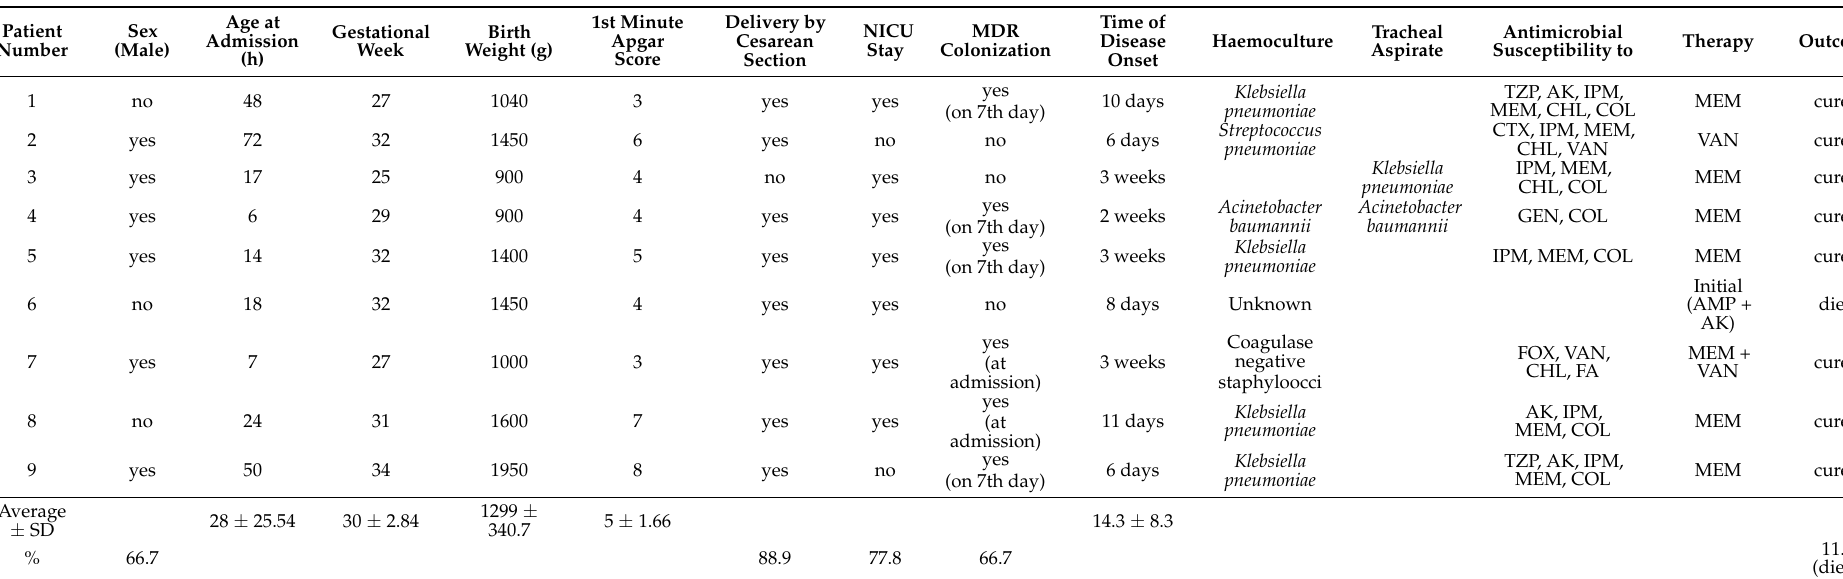
Table 2. Demographic and clinical characteristics, colonization with multidrug-resistant (MDR) bacteria, causative agent, susceptibility to antimicrobial agents, antibiotic therapy and outcome in nine patients that developed infection during the neonatal